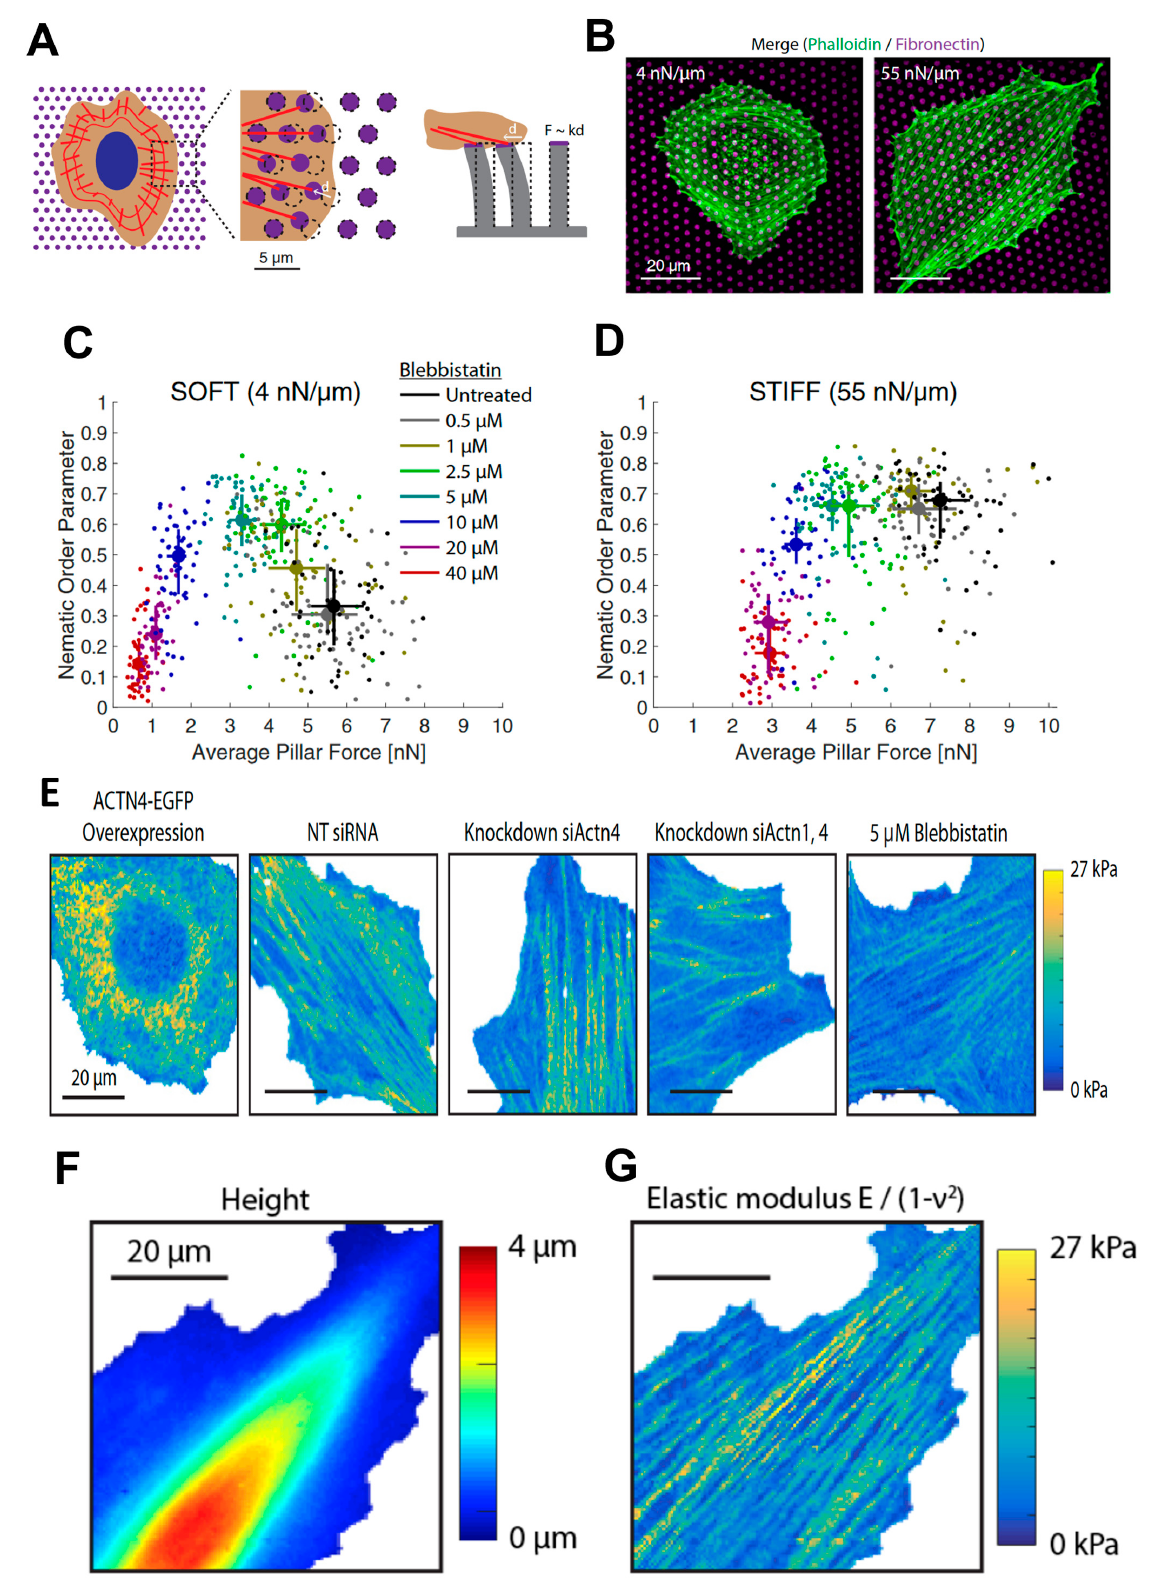
Figure 2. ( A ) Representation of micropillar experiments showing actin (red) and the fibronectin layer on top of the pillars (magenta). ( B ) Cell shape was modulated by substrate stiffness. REF52-WT fibroblasts had a round shape when seeded onto soft (Left) micropillar substrates, while they spread on stiff (Right) micropillar substrates. ( C ) Nematic order parameter versus average traction stress